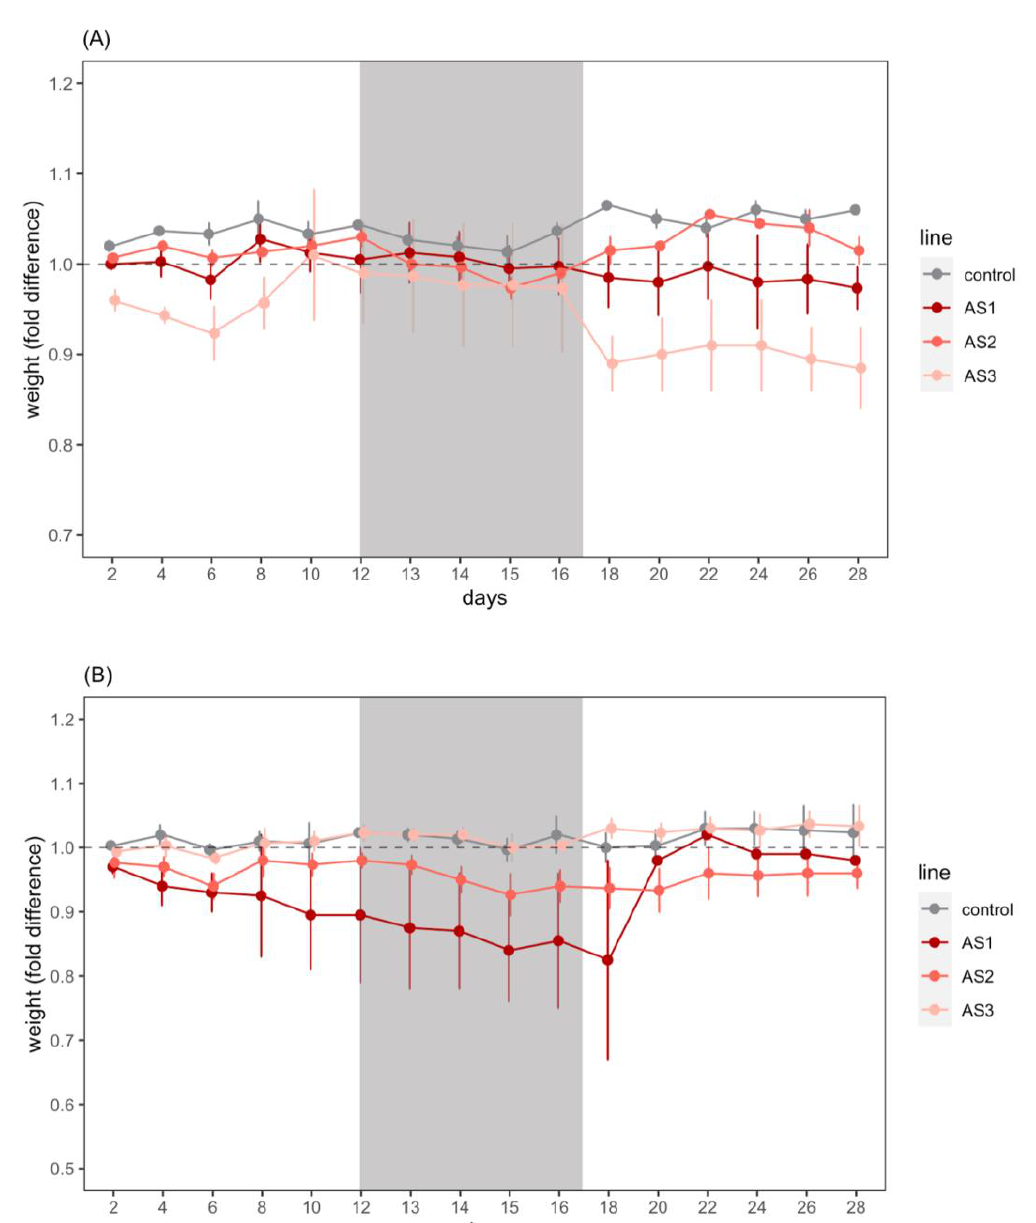
SF2: Bird weight changes (mean ± s.e) in artesunate-treated ( A ) and untreated ( B ) birds. Shaded area corresponds to the 4-day treatment period. Untreated birds were sham injected with the artesunate solvent. Dashed line indicates the baseline bird weight at the start of the experiment (day 0). Bars above/below the dashed line indicate an increase/decrease in parasitaemia with respect to day